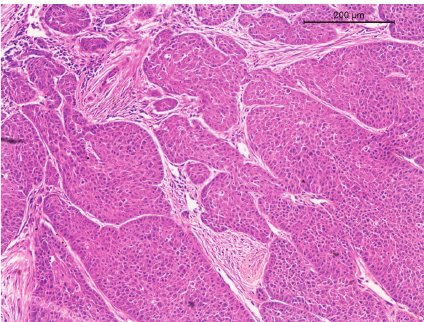
Figure 1: Histopathological appearance of of the canine nasal carcinoma. Note the proliferation of epithelial cells. Note moderate cellular pleomorphism. Hematoxylin and eosin (HE). Bar = 200 𝜇 m.